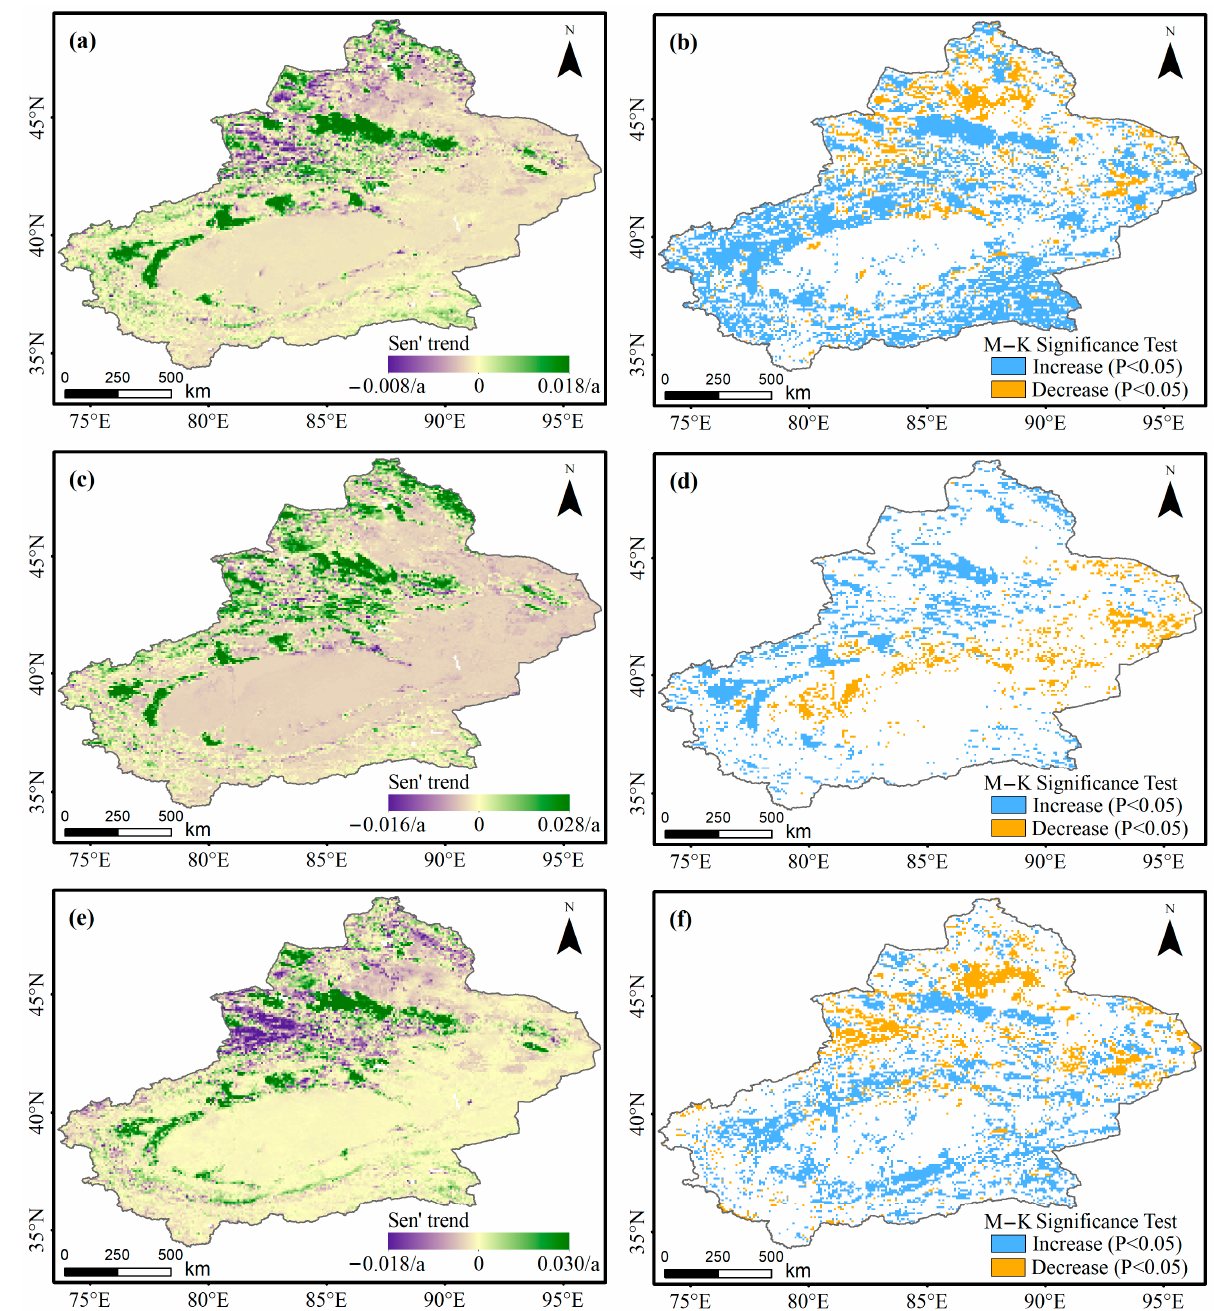
Figure 6. NDVI trends (left) and M–K significance test (right) over the JJA in Xinjiang, China, from